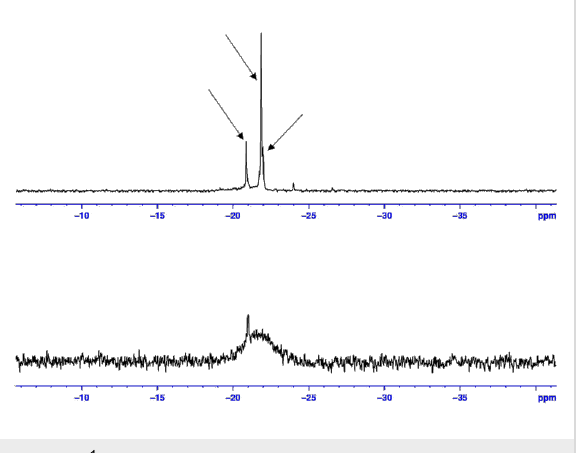
Figure 3: 1 H NMR spectrum of 3b (10 mM) in D 2 O at 25 °C (below) and 60 °C (above).